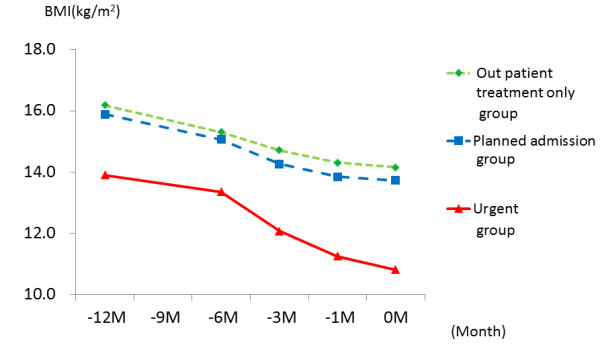
Longitudinal pattern of BMI over the year before the first consultation.